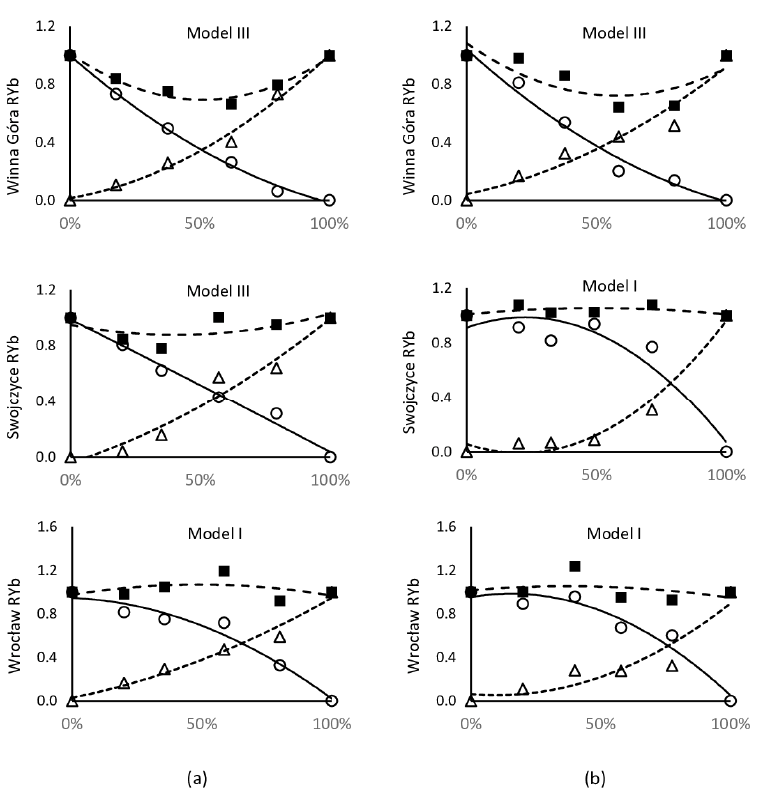
Figure 2. The replacement competition model for the relative biomass yield (RYb) of winter wheat and cornflower (B) in the 2017–2018 season (classified according to the t -test and p <0.05). ( a ) competition between WW and B resistant (R) and ( b )competition between WW and herbicide-susceptible cornflower (S). Legend: o—WW; ∆ —R ( a ) or S ( b ), □ —WW + R ( a ) or WW + S ( b ). The competition between wheat and both cornflower biotypes, as demonstarted by the number of seeds per plant (Figure 3, Table S5), revealed distinct patterns than for plant biomass. In Swojczyce and Wroc ł aw, model IIb was recorded for both cornflower biotypes (R and S). WW was more competitive than cornflower (B); the higher relative productivity of WW was indicated in the mixture (convex line) than the relative yield of B (concave line). In Winna Góra, on the other hand, there was no competition in seed production between each of tested cornflower (R or S) and winter wheat (model I).